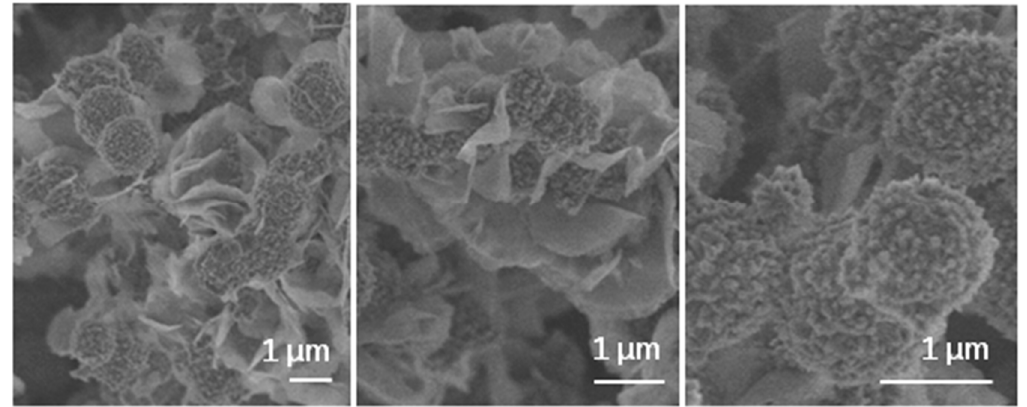
Figure 8. High magnification FEG-SEM secondary electron micrographs of the MTA Repair HP set material after 72 h SBF soaking.